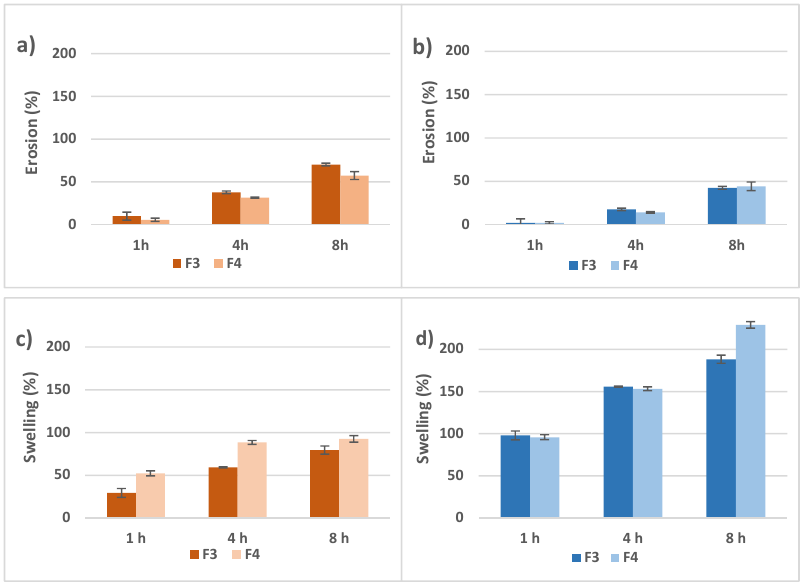
Figure 4. Accumulative erosion percentages for F3 and F4 in ( a ) FaSSGF and ( b ) FaSSIF and Figure4. AccumulativeerosionpercentagesforF3andF4in( a )FaSSGFand( b )FaSSIFandaccumulative accumulative swelling percentages for F3 and F4 in ( c ) FaSSGF and ( d ) FaSSIF. swelling percentages for F3 and F4 in ( c ) FaSSGF and ( d )